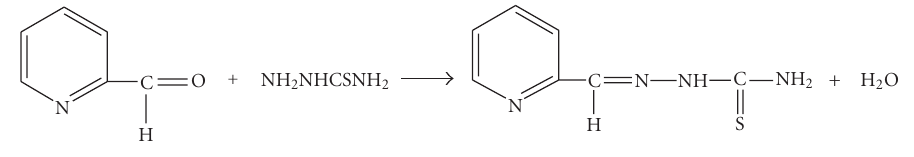
Figure 1: Synthesis and structure of ligand. Table 1: Analytical data for the ligand and its Zn(II) and Hg(II)